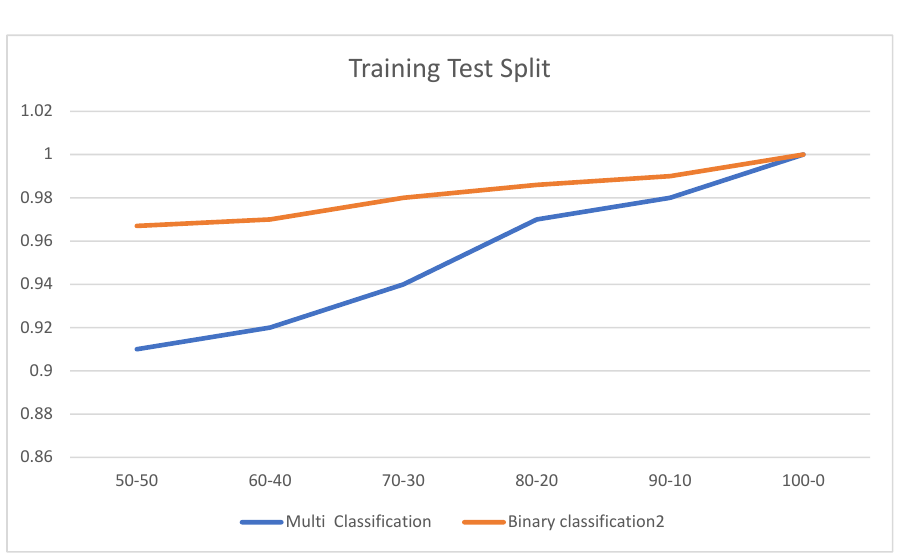
Figure 8. Accuracy of the proposed technique for various training subsets.